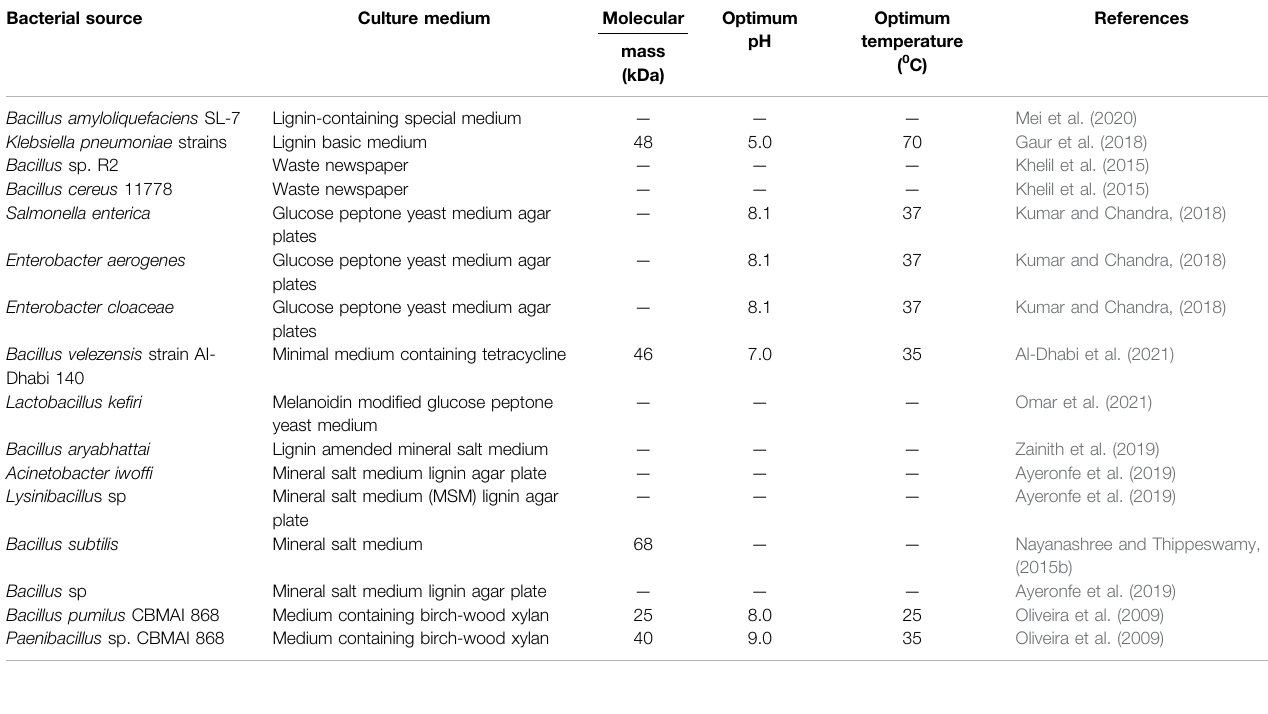
TABLE 2 | List of sources and characteristics of bacterial MnPs.